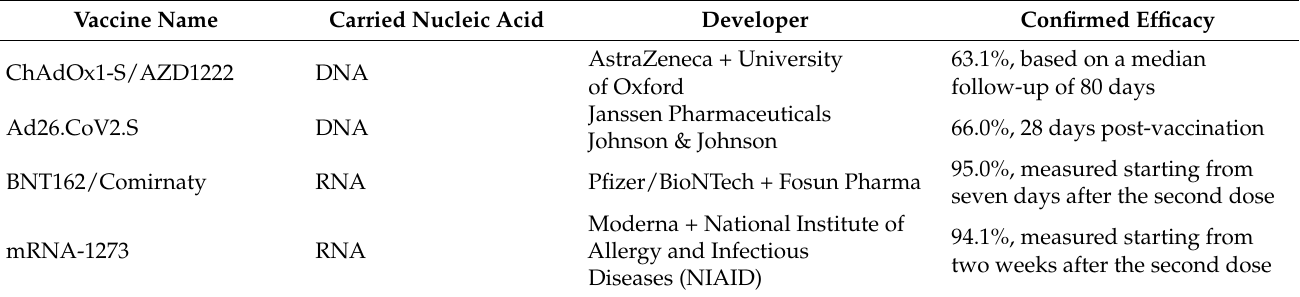
Table 1. Some of the most used nucleic acid-based vaccines in Western